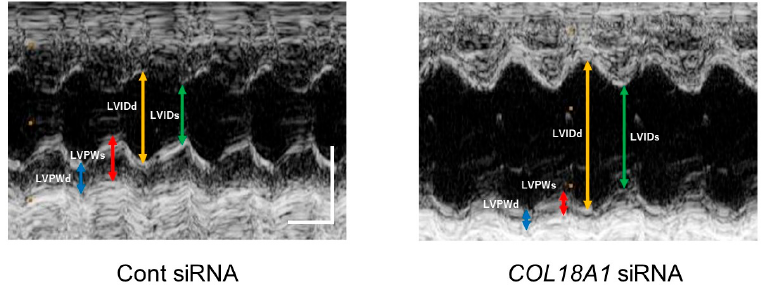
Figure 5. The M-mode echocardiographic image from parasternal short axis view of the left ventricle at the level of papillary muscles in siRNA-injected myocardial infarction model rats. After the ligation of the left anterior descending artery (LAD) in rats, sixteen µg of COL18A1 siRNA or Cont siRNA was injected into the infarcted myocardium. Two weeks after the operation, echocardiography was performed. Representative images of M-mode on the parasternal short axis view of the left ventricle are shown (Cont siRNA: n = 6, COL18A1 siRNA: n = 6). Scale bar: 100 msec (horizontal) and 5 mm (vertical). LVIDd: left ventricular internal dimension at end-diastole, LVIDs: Left ventricular internal ventricular posterior wall at end-systole. Table 2. Echocardiographic parameters in siRNA-injected myocardial infarction model rats. Parameters Unit Cont siRNA( n = 6) COL18A1 siRNA ( n =